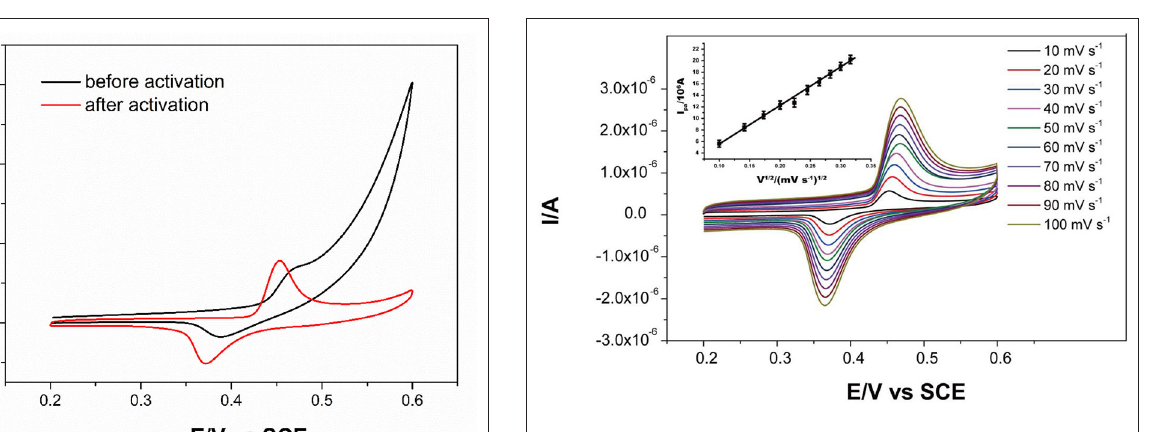
FIGURE 5 | CV curves of Ni-MOFs in the presence of 2.0mM glucose and 0.1M KOH solution at scan rates from 10 to 100mV s − 1 at 25 ◦ C. Inset: calibration curve of anodic peak current to square root of the scan rates (10-100mV s − 1